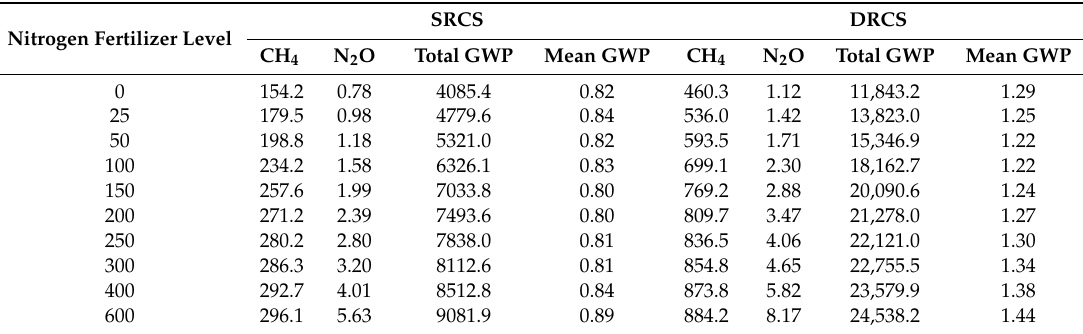
Table 8. Emissions of CH 4 and N 2 O (kg ha − 1 y − 1 ), total GWP (kg CO 2 -eq ha − 1 y − 1 ), and mean